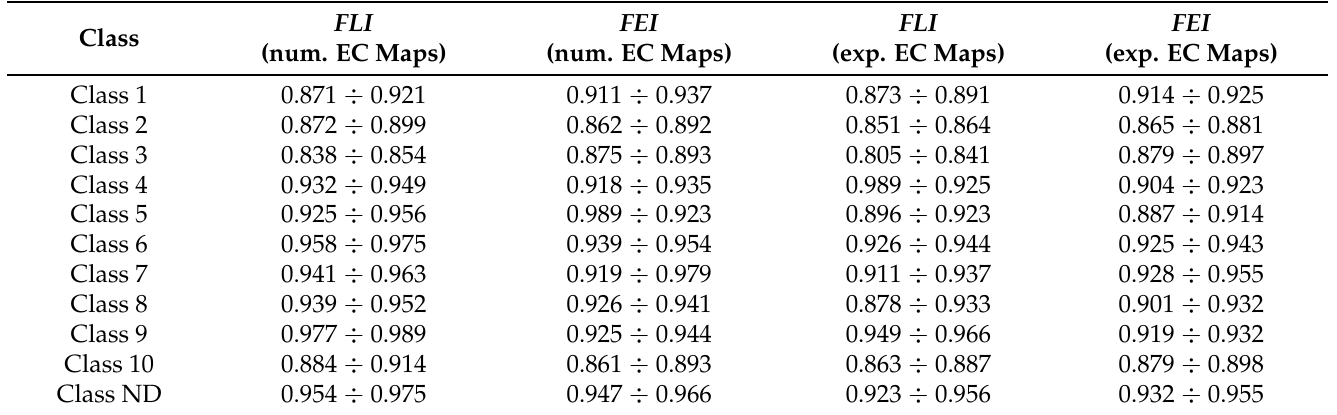
Table 4. FLI and FEI ranges for classes of defects obtained by both COMSOL ® Multiphysics and experimental